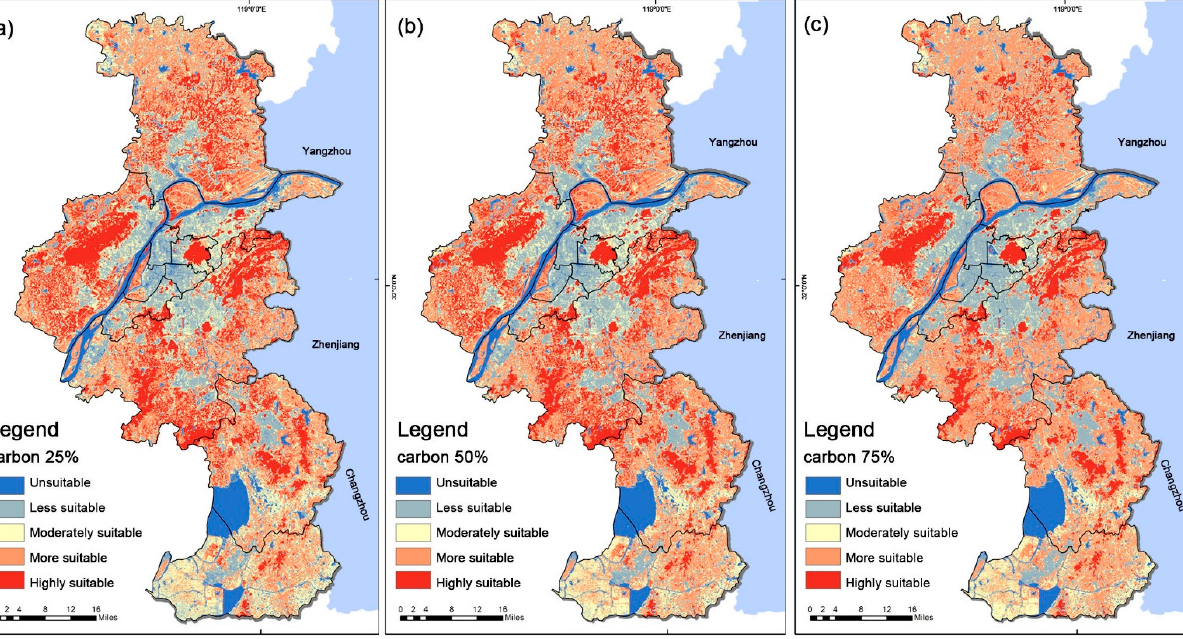
S4 reached a maximum increase of 19.74% and 39.44%, respectively. This shows that as the weight value increases, the area of highest suitability and medium suitability de- creases significantly—most flow to the higher suitability areas and a small portion flow to the less suitable areas. Table 6 shows that when the weights decrease, the areas of S1, S4, and S5 decrease by 75%, with the S5 showing the most significant reduction of 8.28%. The carbon storage has the highest weight, so as its weight decreases, it will increase the weight values of the other factors, resulting in more pronounced fluctuations in the highly Figure 6. Results of sensitivity analysis of F-AHP applied to urban park site selection. ( a ) Sensitivity suitable zone (Figure 7). of the criterion ‘carbon storage’; ( b ) Sensitivity of the criterion ‘temperature’. In the model, ±75% change in the standard weight of carbon storage capacity caused − 13% change in the S1 unsuitable class, 21% change in the S2 less suitable class, 41% change in the S3 moderately suitable class, 41% change in the S4 more suitable class and 23% change in the S5 highly suitable class. The changes in the standard weights of the carbon storage capacity significantly affected the moderately suitable S3 and the more suitable S4. The area of the S3 and the S5 reached a maximum reduction of 32.66% and 31.41%, respectively, when the weight was changed by +75%. Meanwhile, the S2 and the